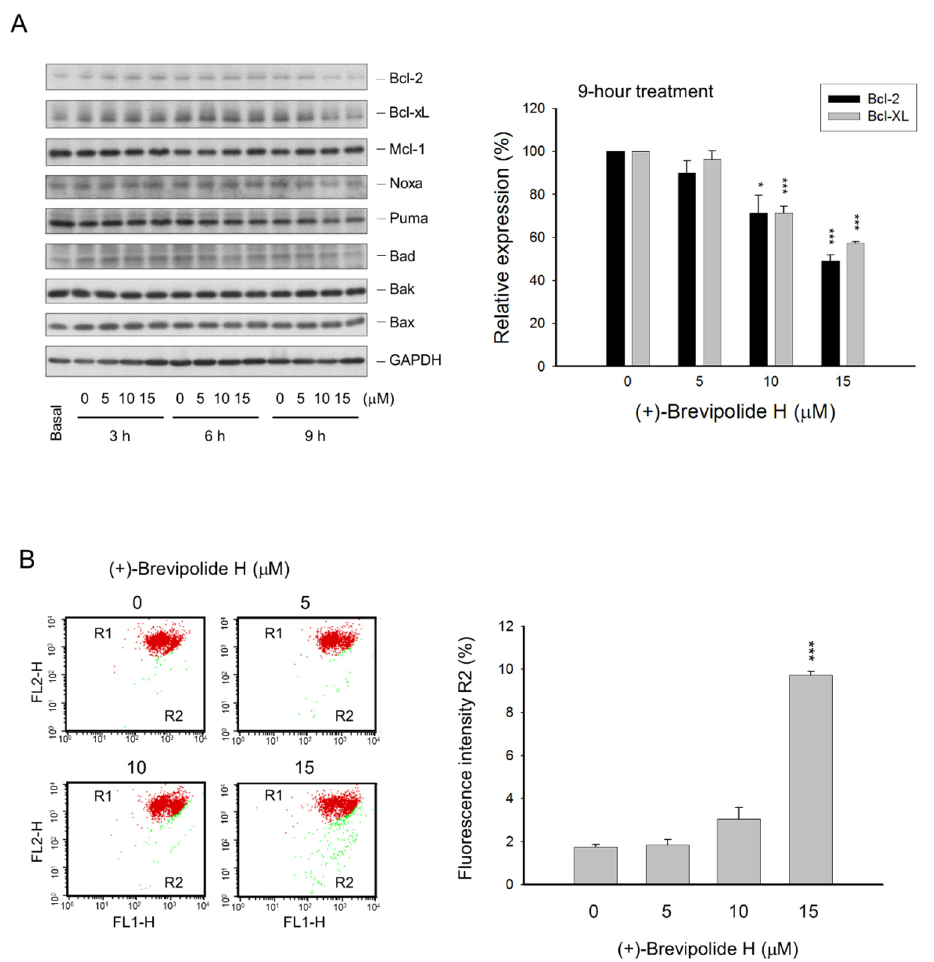
Figure 7. Effect of (+)-brevipolide H on the expressions of Bcl-2 family of proteins and mitochondrial membrane potential in PC-3 cells. ( A ) The cells were incubated in the absence or presence of (+)-brevipolide H for the indicated concentrations and times. The cells were then collected and lysed for the detection of protein expression by Western blot analysis. Quantitative data under the 9-h treatment are expressed as mean ± SEM of three independent experiments using Bio-Rad Image Lab TM Software; * p < 0.05 and *** p < 0.001 compared with the respective control. ( B ) The cells were incubated in the absence or presence of (+)-brevipolide H for 24 h and then stained with JC-1 to monitor mitochondrial membrane potential. Quantitative data were analyzed using BD CellQuest TM Pro Software and expressed as mean ± SEM of three independent experiments; *** p < 0.001 compared with the control.